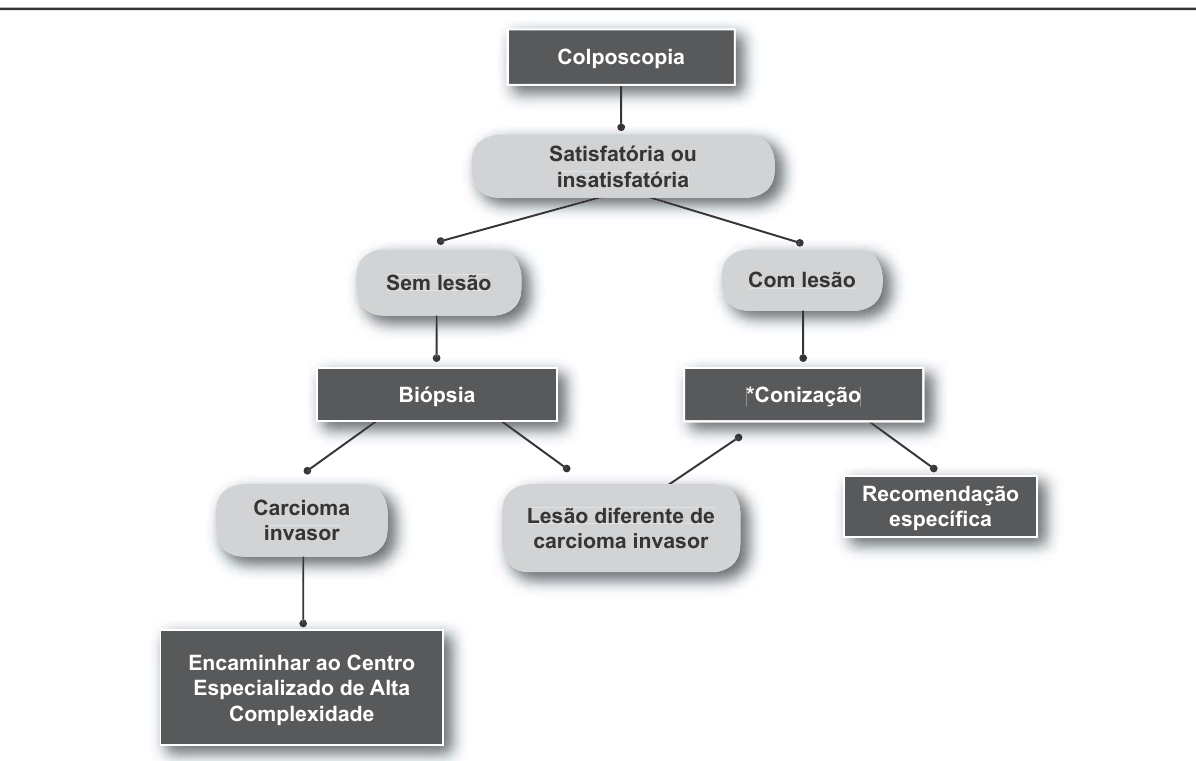
Figura 8 – Recomendações para condutas diante de pacientes com lesão de alto grau, não se podendo excluir microinvasão ou carcinoma epidermóide invasor Nota técnica:*Exceto nos casos com indícios clínicos sugestivos de invasão, os quais serão encaminhados ao centro especializado de alta